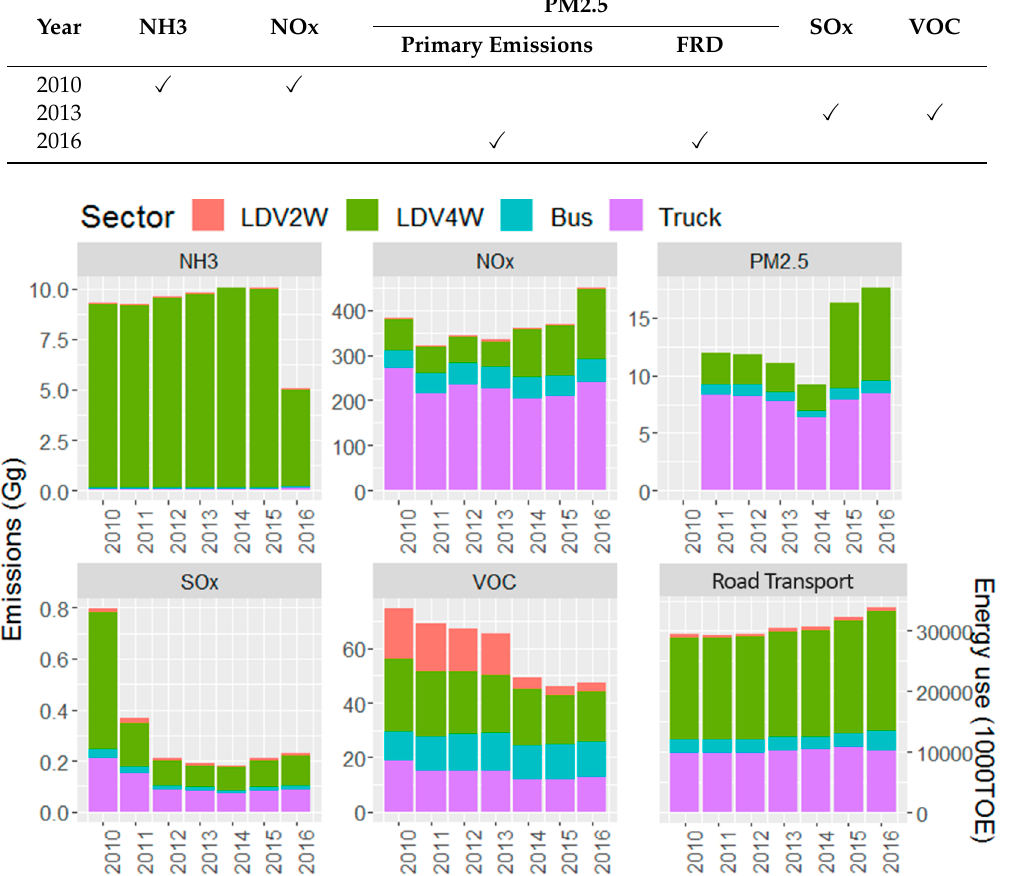
Figure 2. Reclassified emissions and energy use in road transportation. Note: Total energy use of road transportation is from the energy balance table in the Yearbook of Energy Statistics [44], and the sectoral share [47–49] is applied to total energy use.